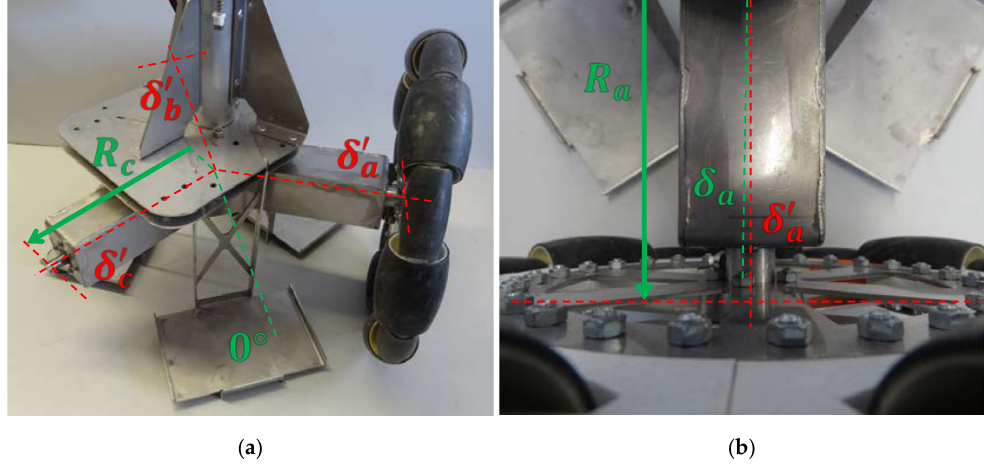
Figure 5. General view ( a ) and detail ( b ) of the angular orientation of the front-left wheel (wheel a) relative to the mobile robot frame: δ a depicts the nominal or design value (green font and lines) and δ (cid:48) a is the real or effective value (red font and